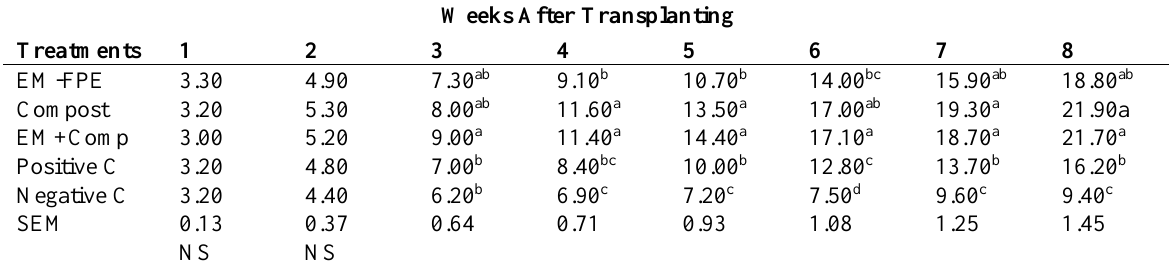
Table 4 Effect of treatment on the mean number of leaves of Meloidogyne incognita infected tomato plants under screenhouse conditions Weeks After Transplanting Treatments